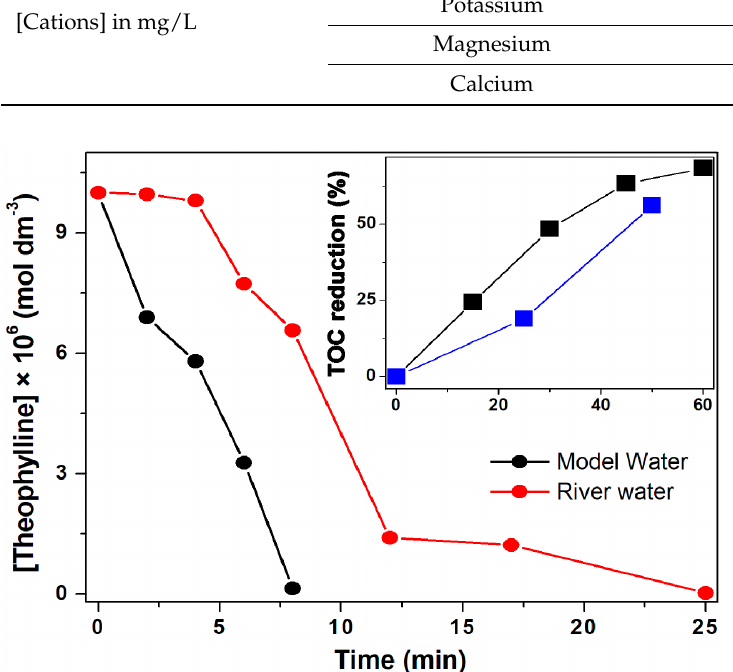
Figure 5. Photo-degradation profile of theophylline (1 × 10 − 5 mol dm − 3 ) in the presence of (black) 5 × 10 − 5 mol dm − 3 H 2 O 2 in model water and (red) in river water. (Inset) TOC reduction in the presence of (blue) 5 × 10 − 5 mol dm − 3 and (black) 1 × 10 − 4 mol dm − 3 H 2 O 2 .